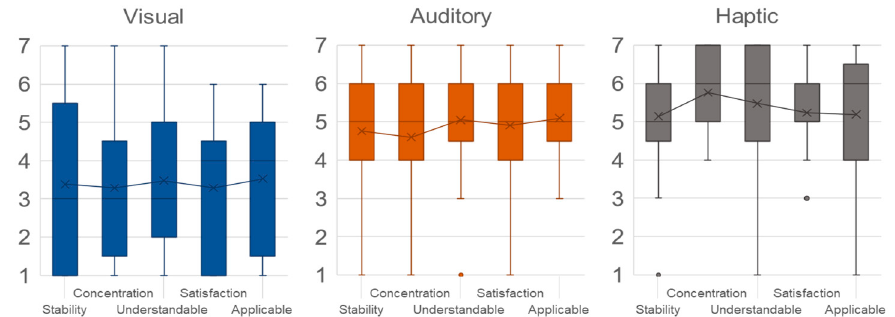
Figure 11. Survey evaluations for single modality TOR ( 𝑛 = 39 ).